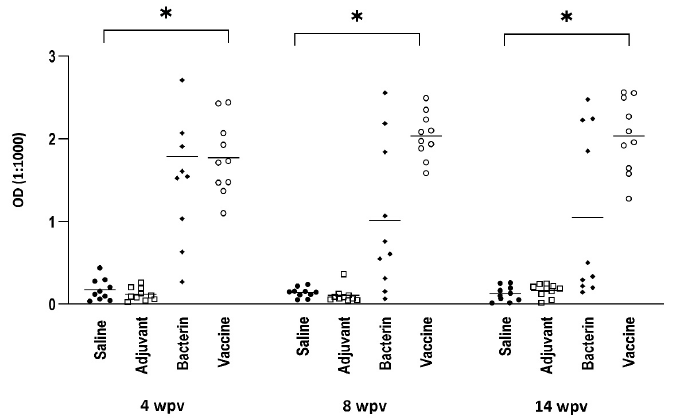
Figure 2. Trout plasma antibody reactivity against the vaccine strain 950106-1/1. ELISA was per- formed using plasma (1:1000) from 4 different fish groups and measured at 4, 8 and 14 weeks post-vaccination (wpv). O.D. values were compared using Kruskal–Wallis test with Dunn’s multiple comparison test. *: p < 0.05. A total of 10 (2 × 5) fish were sampled at each time point from each group. One extreme outlier in the bacterin group at 4 wpv was removed.